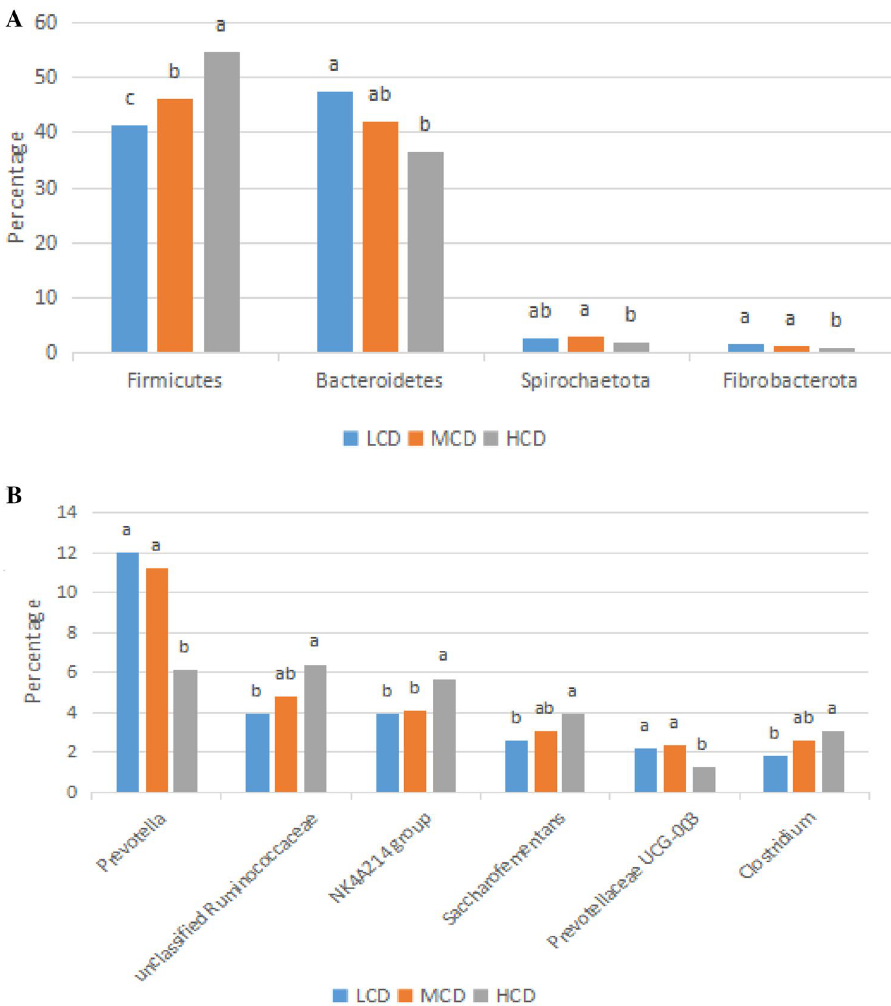
Figure 3. Changes in the relative abundance of ( A ) the most dominant phylum and ( B ) the most dominant genera in the rumen microbial community of cows with different F:C ratios diets. Boxes with a different letter are significantly different at P < 0.05 or P < 0.1 (Firmicutes) by t-test analyses. LCD, 35:65 concentrate:forage; MCD, 50:50 concentrate:forage; HCD, 65:35